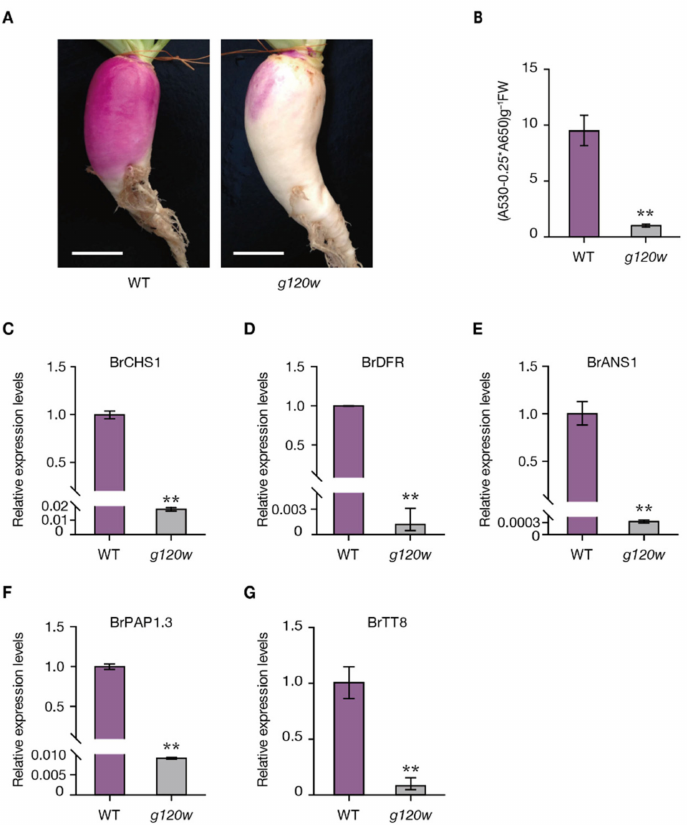
Figure 1. Characterization of g120w mutant. ( A ) Phenotypic variation in the swollen root of the wild type and g120w . Bars = 5 cm. ( B ) Anthocyanin content in wild type and g120w swollen root peel. ( C – G ) Quantitative real-time PCR (qRT-PCR) analysis of BrCHS1 , BrDFR , BrANS1 , BrPAP1.3 , and BrTT8 expression levels in swollen root peels in ( A ). Mean ( ± SD) expression levels were normalized by BrACTIN7 , and results for wild type were set at 1. Asterisks indicate a significant difference between WT and g120w (** p < 0.01, Student’s t -test, n = 3). To characterize the inheritance of g120w , we used g120w as the maternal plant in a cross with the wild type and generated the F 1 population, which was self-pollinated to generate the F 2 population. Phenotypic segregation analysis showed that the F 1 progeny had a purple peel. For the 270 F 2 individuals, 204 had purple peels (PP-type) and 66 had white peels (WP-type), which was consistent with the predicted 3:1 segregation ( χ 2 = 0.833). The genetic analysis of g120w showed that the anthocyanin deficiency trait was caused by a single recessive